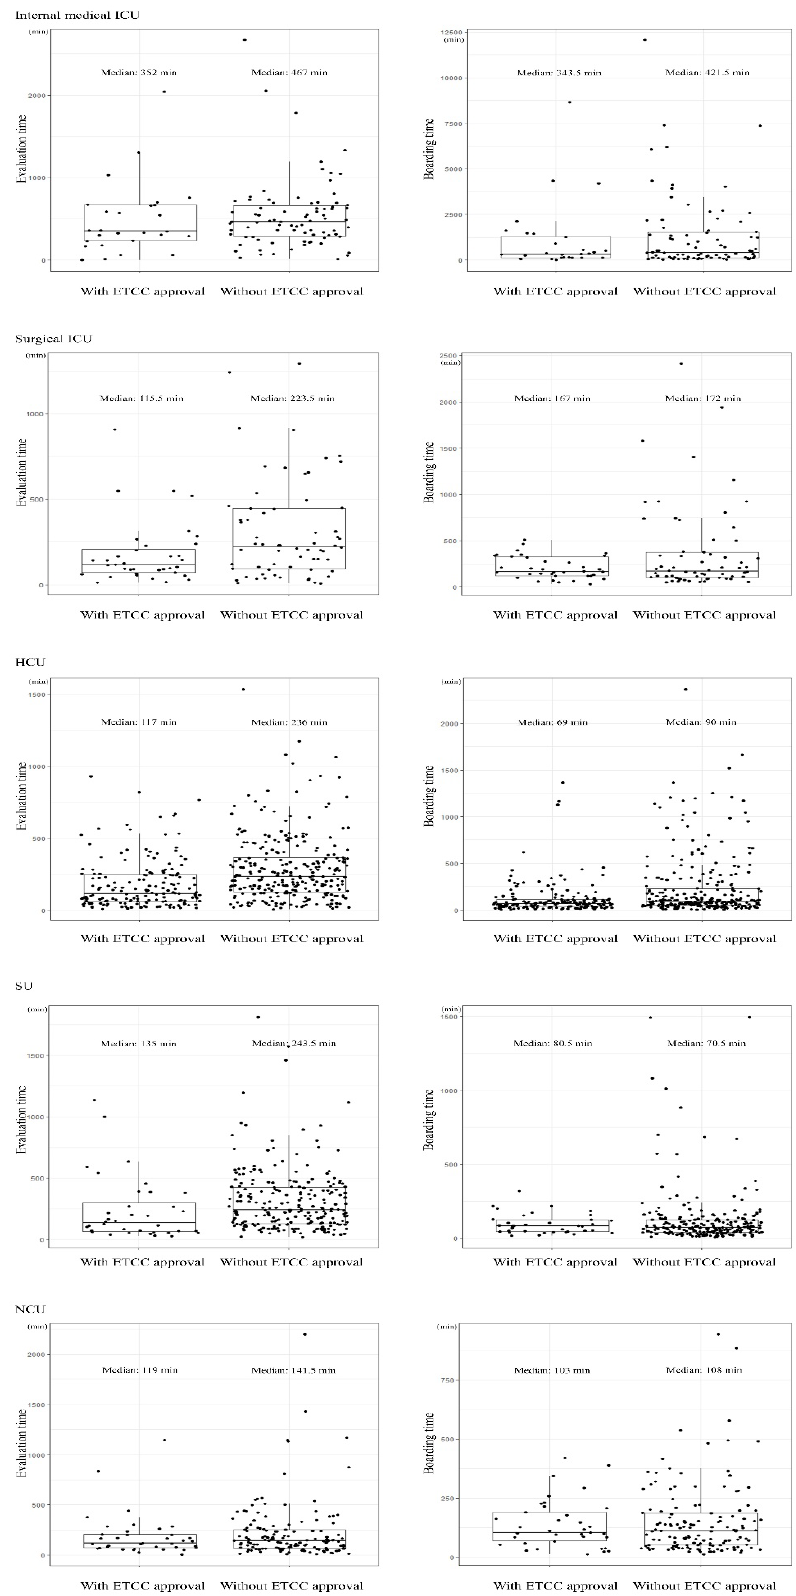
Figure 3. Distribution of outcomes based on intensive care unit category in the entire population. ETCC, emergency transfer coordination